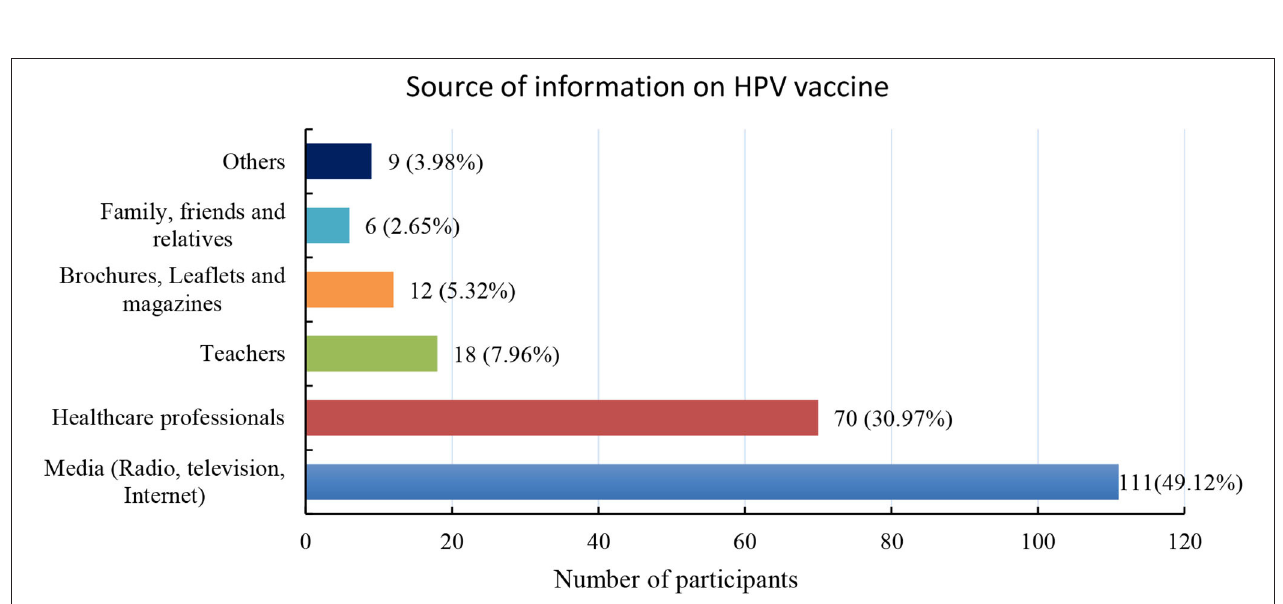
FIGURE 3 | Distribution of source of information the participants obtained on the HPV vaccine in frequency and valid percentages. Media is the most popular source of information on HPV vaccination in Indonesia (49.12%) followed by healthcare professionals